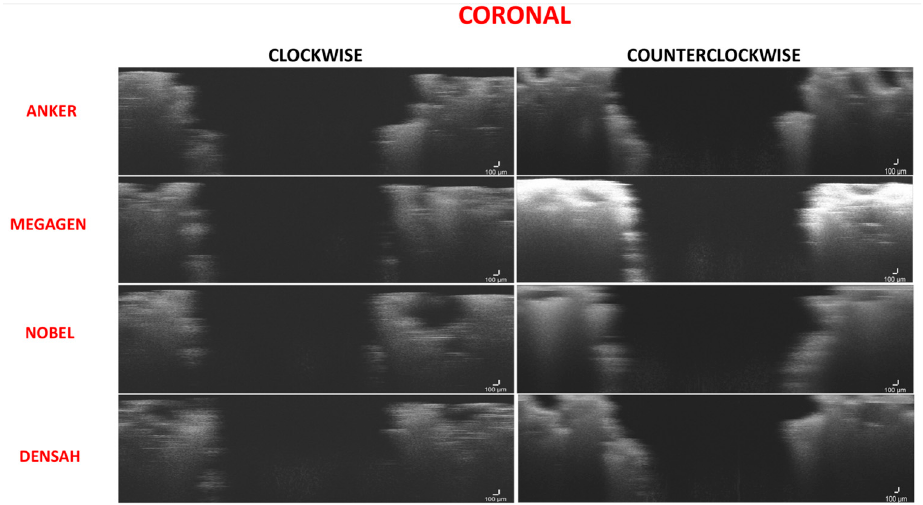
Figure 5. Volume reconstruction for the qualitative evaluation of the microarchitecture. Scanning was completed in a volume of 10 mm × 10 mm. This is a 3D image of the coronal section of the Densah burs group in counterclockwise drilling.